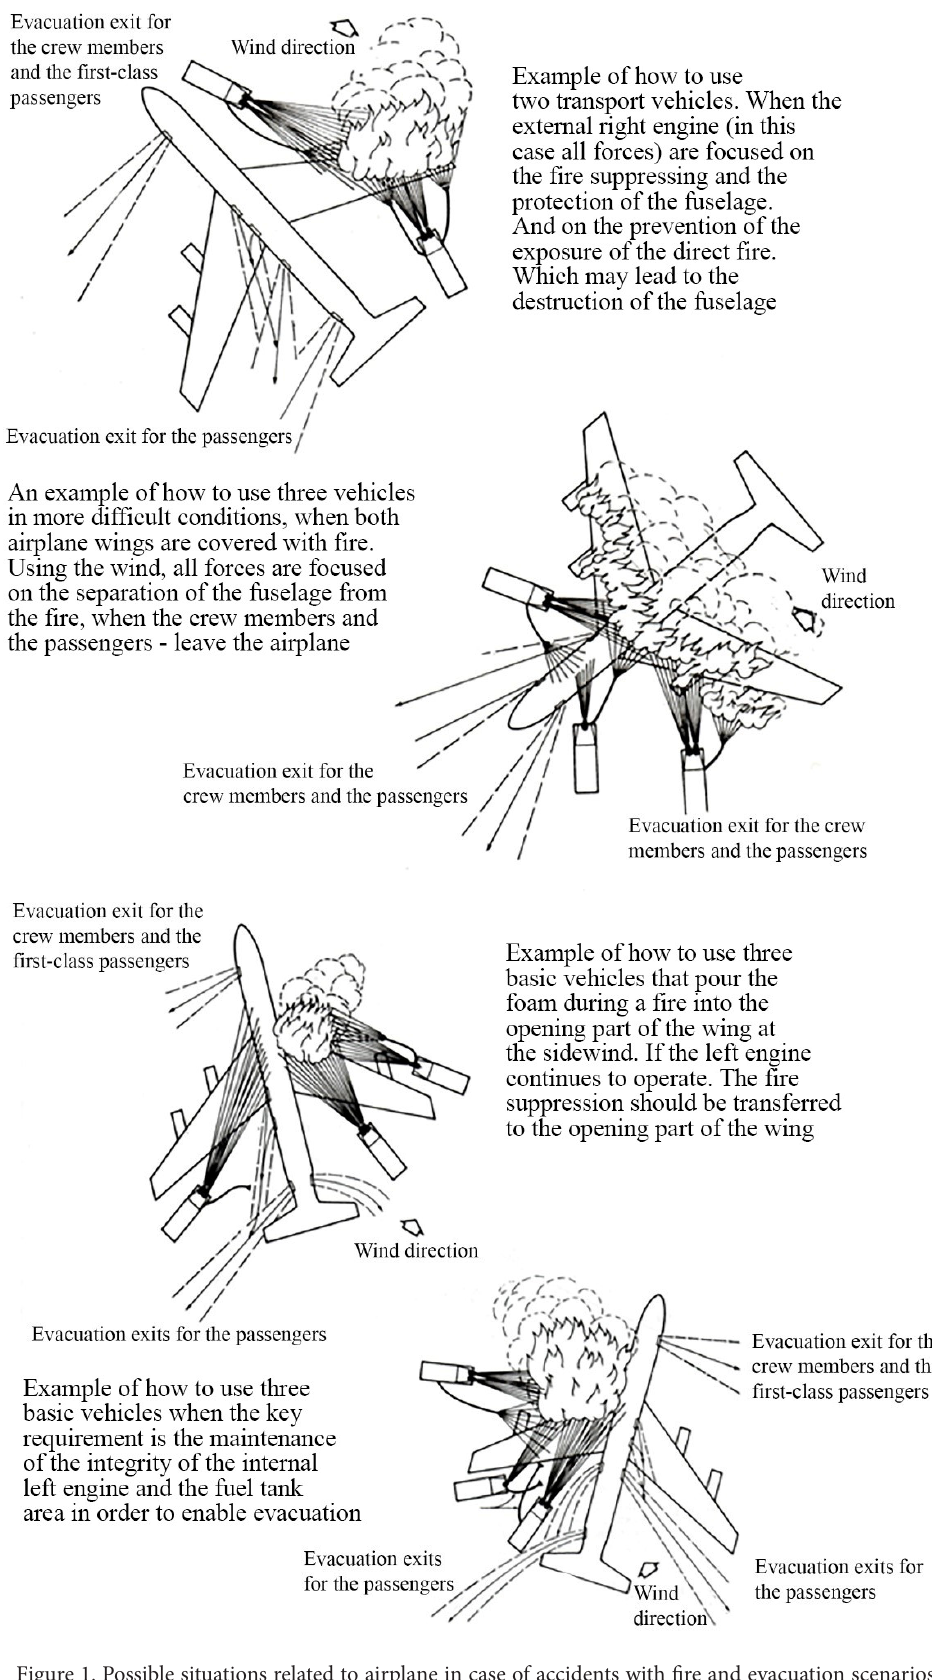
Figure 1. Possible situations related to airplane in case of accidents with fire and evacuation